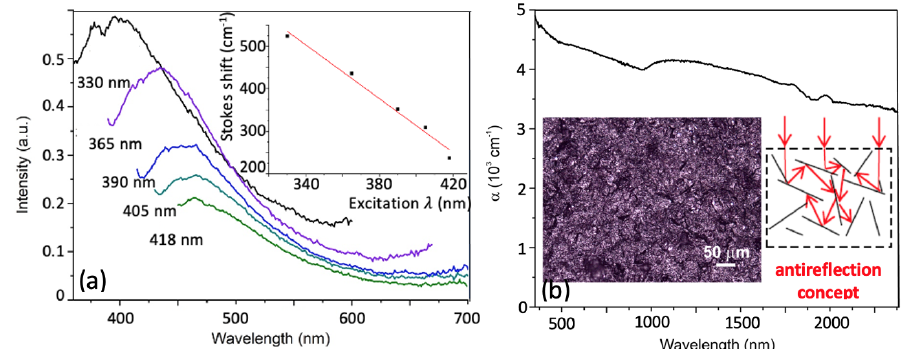
Figure 3. ( a ) The photoluminescence spectra of a depleted liquid phase of the studied carbon system registered at different excitation wavelengths. The inset shows the Stokes shift dependence on the excitation wavelength; ( b ) the absorption spectrum of a deposited sponge film whose optical image is shown in the inset. The concept of increased light absorption due to high porous sponge surface is schematically illustrated on the right hand side of the insert of the Figure